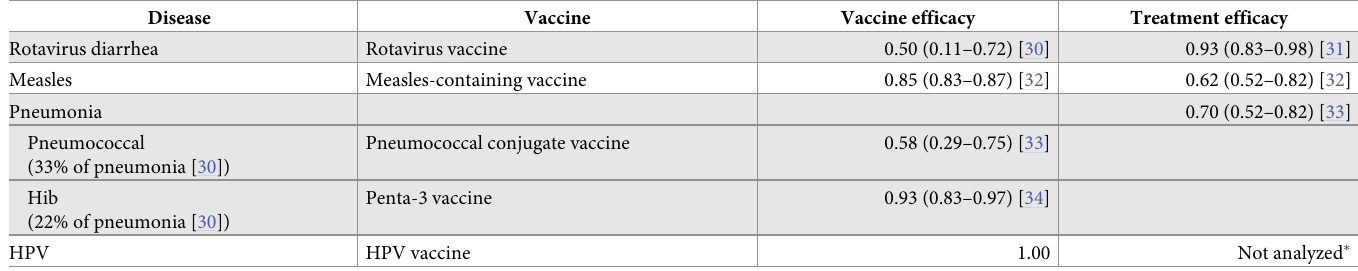
Table 2. Vaccine and treatment efficacies for rotavirus diarrhea, HPV, measles, and pneumonia (pneumococcal and Hib) used in the